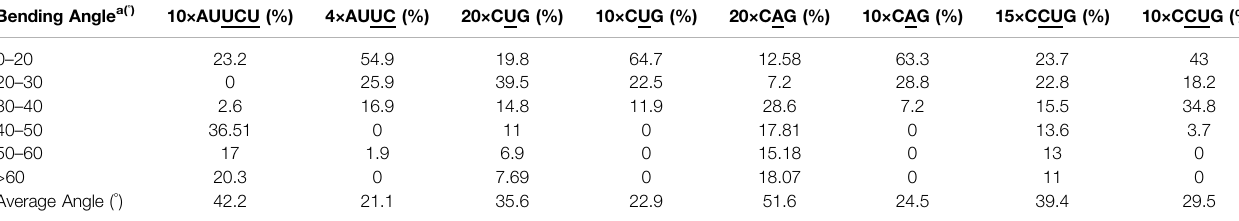
TABLE 2 | Bending angles calculated for average structures of clusters extracted from MD trajectories. Bending Angle a( ° ) 10×AUUCU (%) 4×AUUC (%) 20×CUG (%)